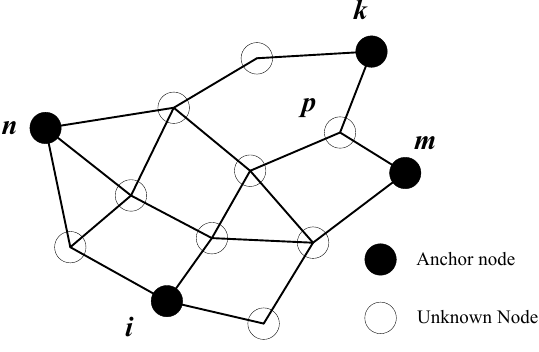
Figure 3. Calculation schematic diagram of correction coefficient.